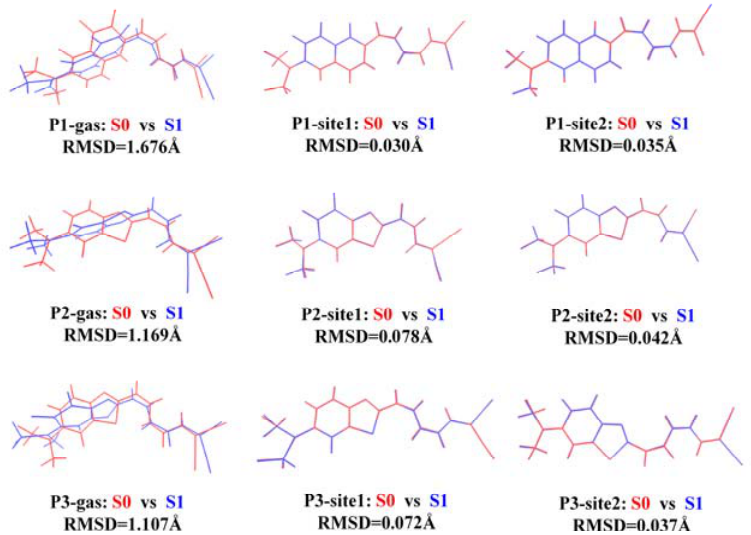
Figure 8. Geometry changes between the ground state and the first excited state for P1, P2, and P3 in different microenvironments.